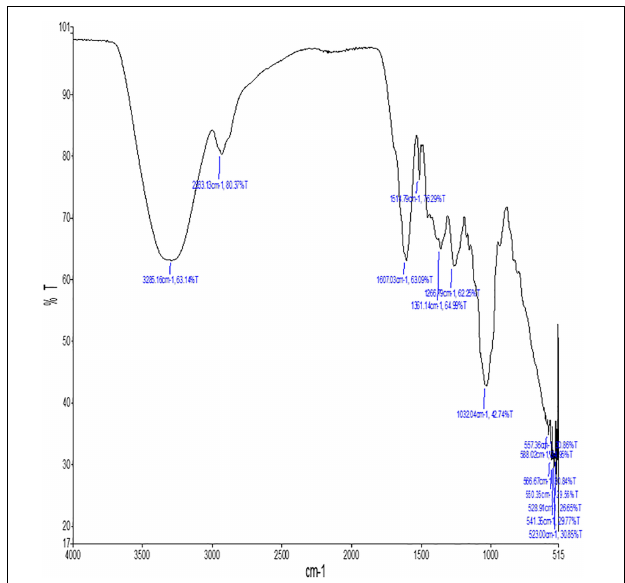
FIGURE 4 | Fourier Transform Infrared Spectrophotometer (FTIR) of methanolic extract of O. limbata .